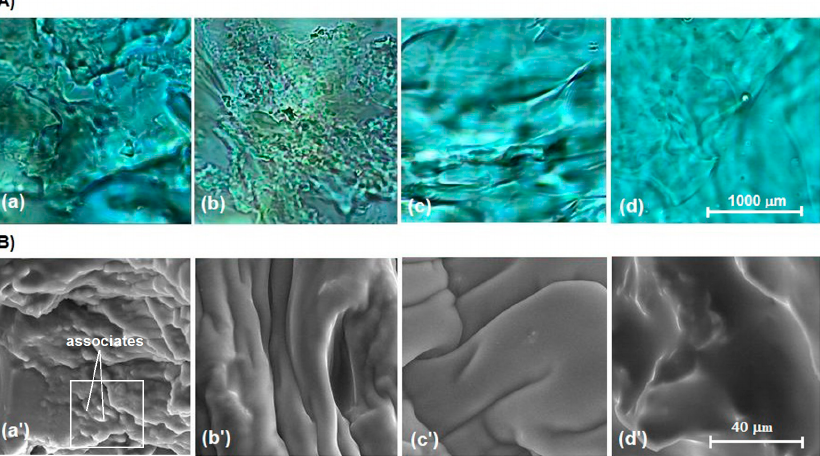
Figure 8. POM ( A ) and SEM ( B ) images for PSFEtP + solutions and corresponding lyophilized samples obtained in DMF at different concentrations: 5.01 g/mL ( a , a’ ), 8.02 g/mL ( b , b’ ), 10.06 g/mL ( c , c’ ), 12.43 g/mL ( d , d’ ).